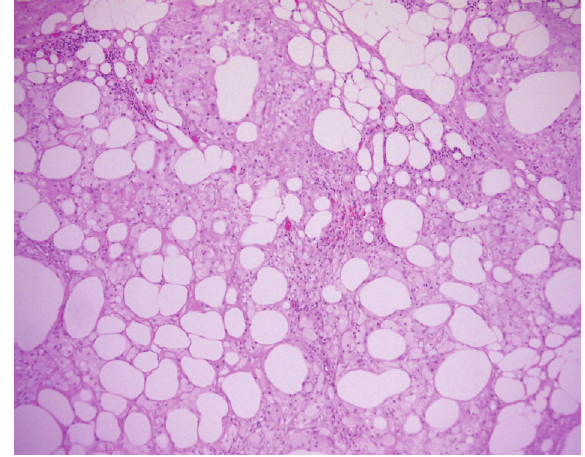
Figure 2: Idiopathic retractile sclerosing mesocolitis: lipid-laden foamy cells and chronic granulomatous inflammation of mesocolon (emathoxilyn-eosin 100x original magnification).